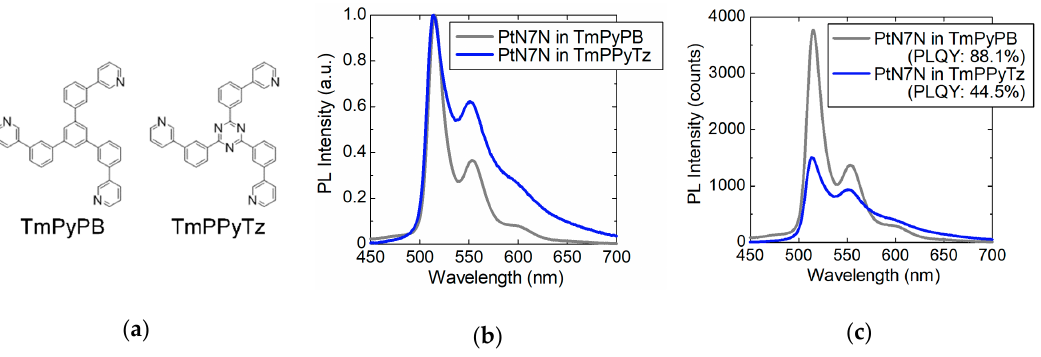
Figure 3. The molecular structures and PL spectra of PtN7N in TmPyPB and TmPPyTz: ( a ) molecular structures; ( b ) normalized PL spectra; and ( c ) non-normalized PL spectra.